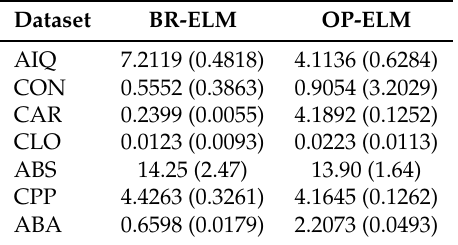
Table 12. Result of regression test—RMSE.